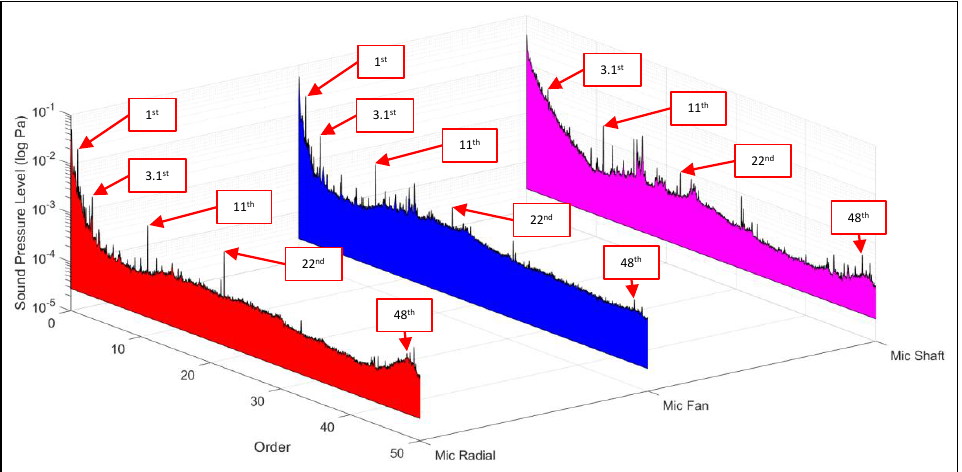
Figure 13. Average order spectra of sound pressure levels measured using radially aligned, fan-facing, and shaft-facing microphones.